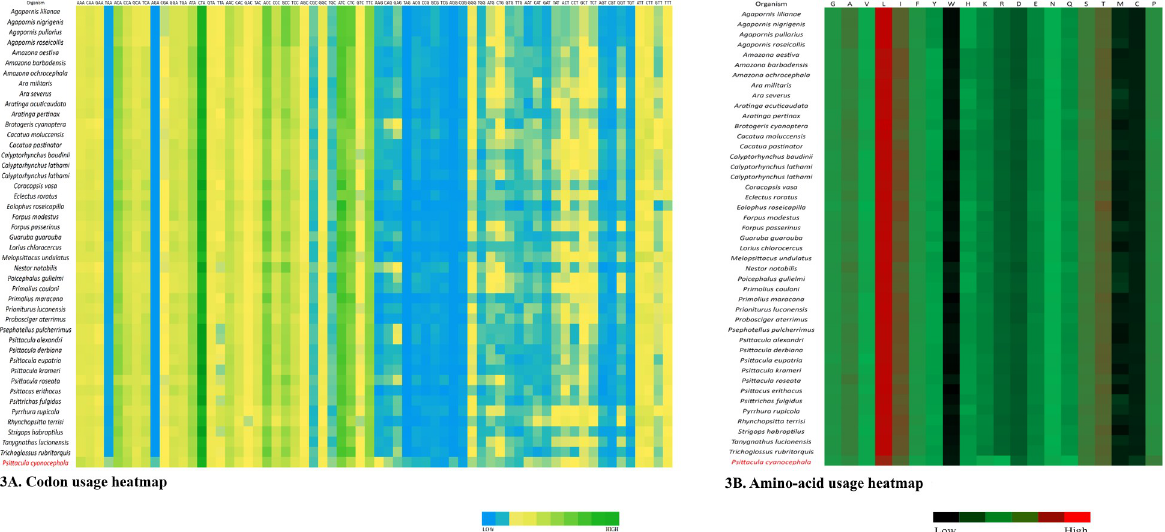
Fig 3. Heatmaps based on (A) codon usage and (B) amino acid usage of all the 45 species compared in this study. https://doi.org/10.1371/journal.pone.0241098.g003 positions on amino acid acceptor arm, DU stem and T ψ C stem. The study found trn Glu , and trn Ser (GCU) contained two wobble positions present on the amino acid acceptor arm and